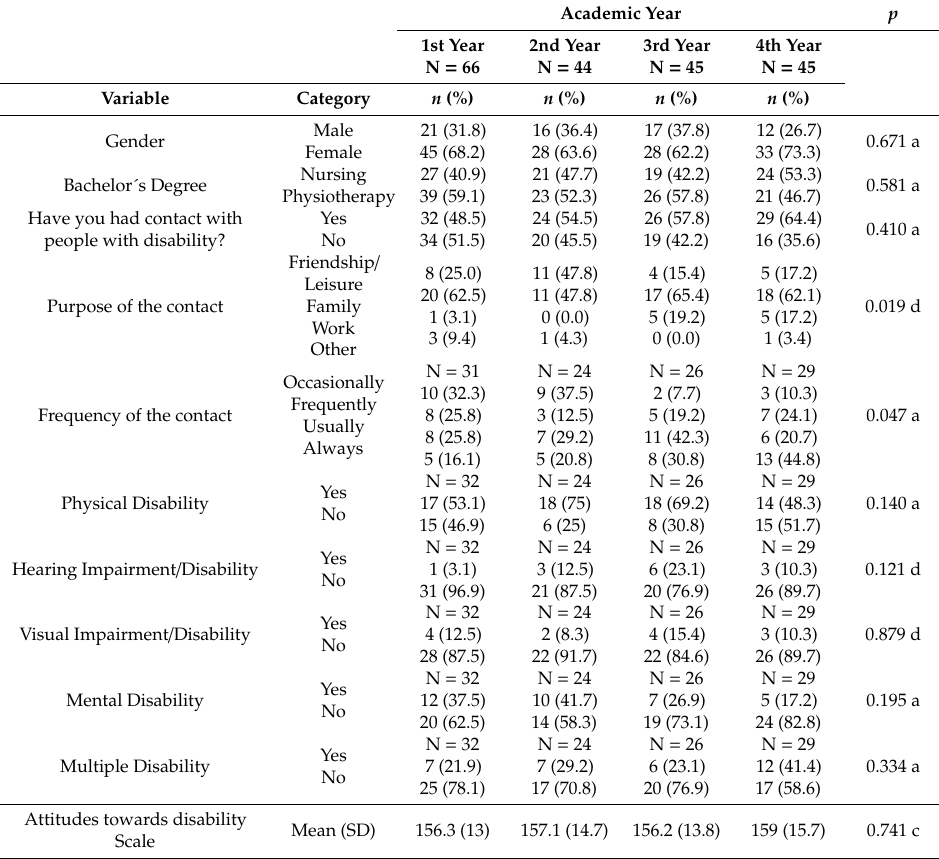
Table 4. Comparisons by academic